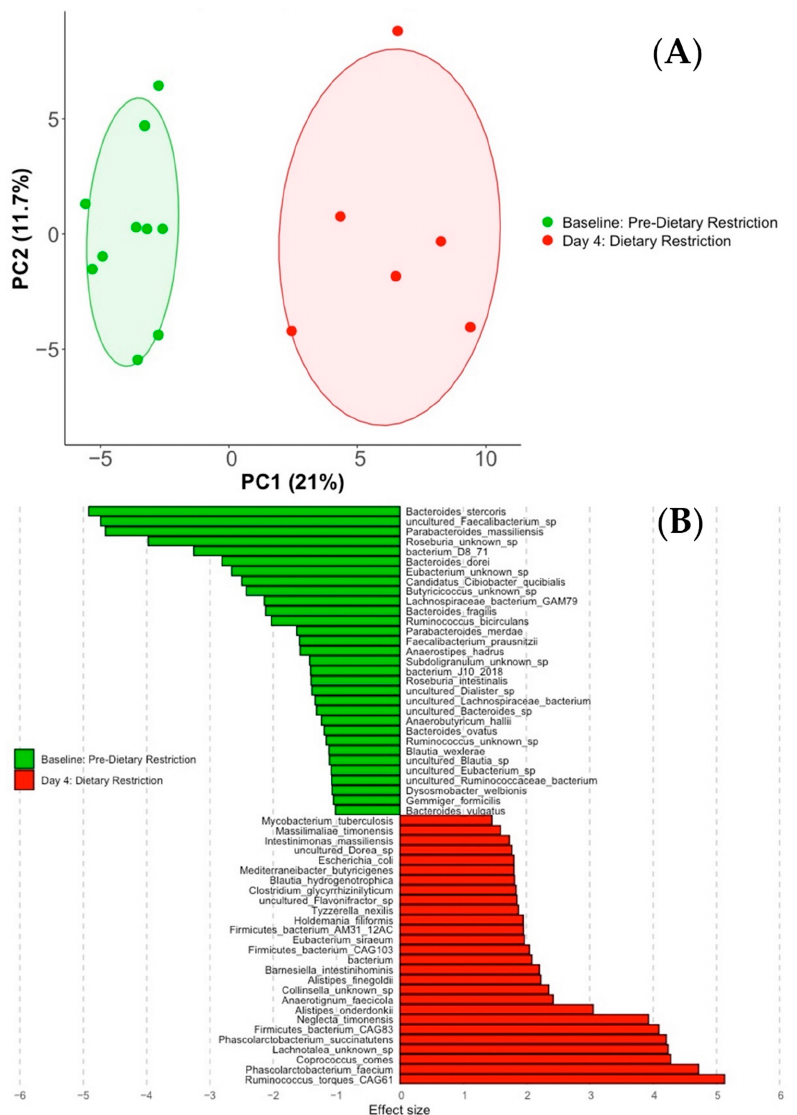
Figure 6. Baseline v. Day-4. Principal component analysis of species present between the two conditions ( A ). Effect size graph of significantly different species (FDR p < 0.05, effect size > 1) ( B ). Supplementary Figure S4 and Supplementary Table S3 show similar analyses